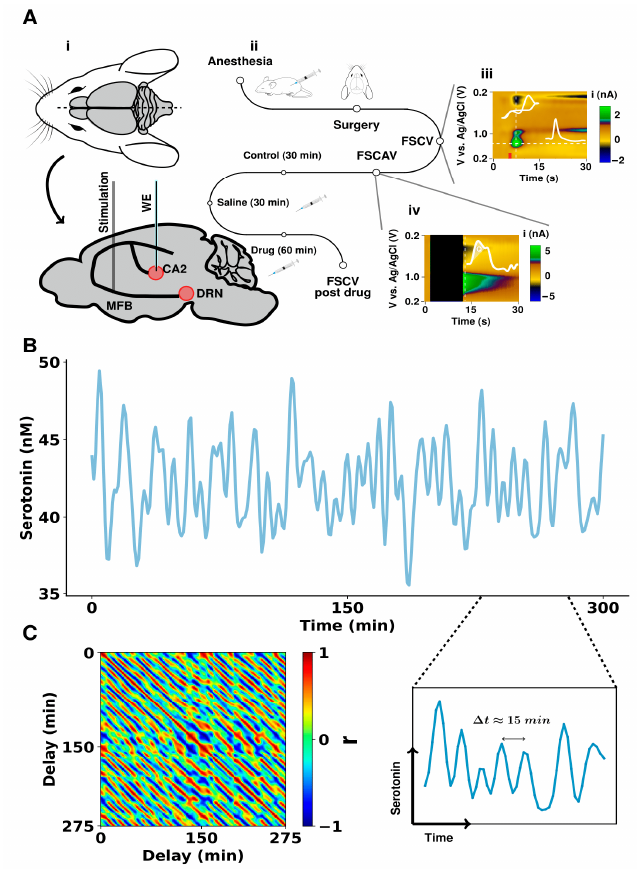
Figure 1. In vivo hippocampal serotonin fluctuations in mice. ( A ) Schematic of experimental paradigm for serotonin measurements with FSCV (evoked) and FSCAV (basal). ( Ai ) shows the position of the stimulation electrode in the medial forebrain bundle and the working electrode (WE) in the CA2 region of the hippocampus. The reference electrode was positioned in the opposite hemisphere of the mouse brain. ( Aii ) shows the timeline for experiments where an antidepressant was acutely administered to the mouse. ( Aiii , Aiv ) show a raw FSCV acquisition and an FSCAV acquisition, respectively, with inset cyclic voltammogram and a current vs. time trace. The marked area under the curve (charge, Q) was used to obtain estimations of basal serotonin levels. ( B ) A 300-min in vivo FSCAV acquisition from the CA2 region of a mouse hippocampus. A 50-min section of this is also directly shown below. The signal was low-pass filtered with a 3rd order Butterworth filter and with a 0.005 Hz cutoff frequency. ( C ) Sliding window correlation of the time series (shown in ( A )) with itself, with a window size of 25 min. The high (positive and negative are presented in red and blue, respectively) correlation stripes show the repetitive fluctuation pattern of the time